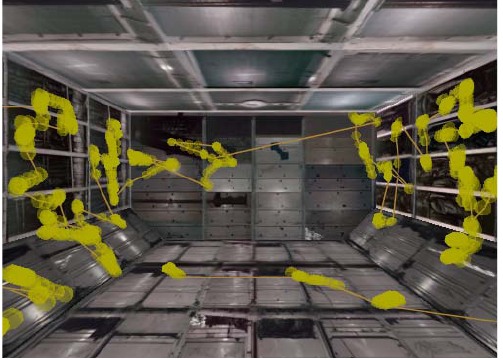
Figure 8. “Fixation Points for